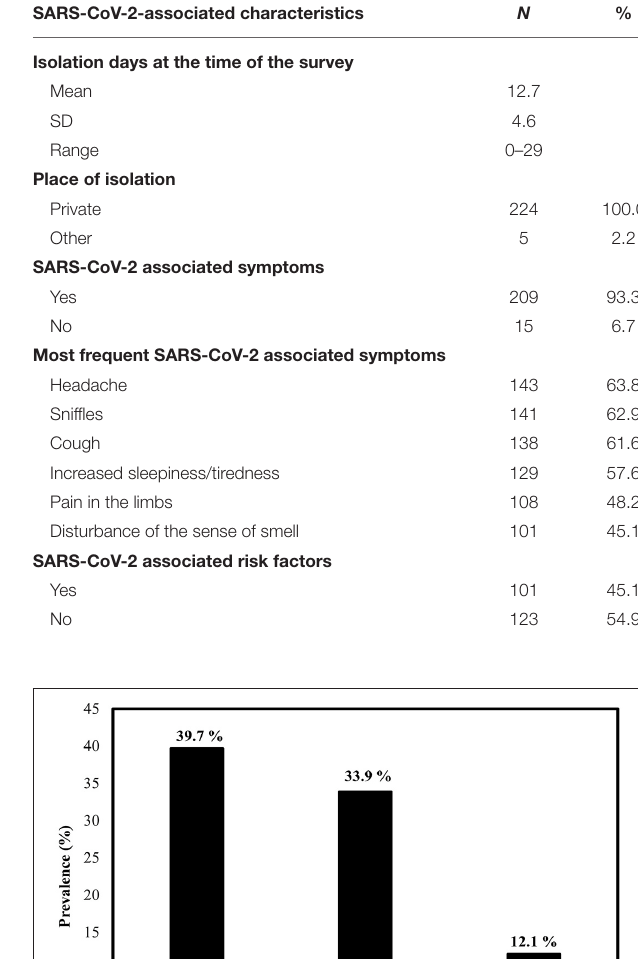
TABLE 2 | Study population characteristics: SARS-CoV-2-associated characteristics ( n = 224). SARS-CoV-2-associated characteristics